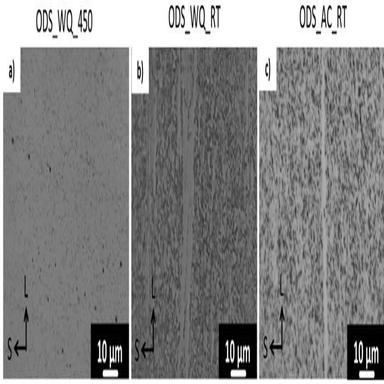
Optical microscope images of the etched bulk microstructure of a) ODS_WQ_450, b) ODS_WQ_RT and c) ODS_AC_RT